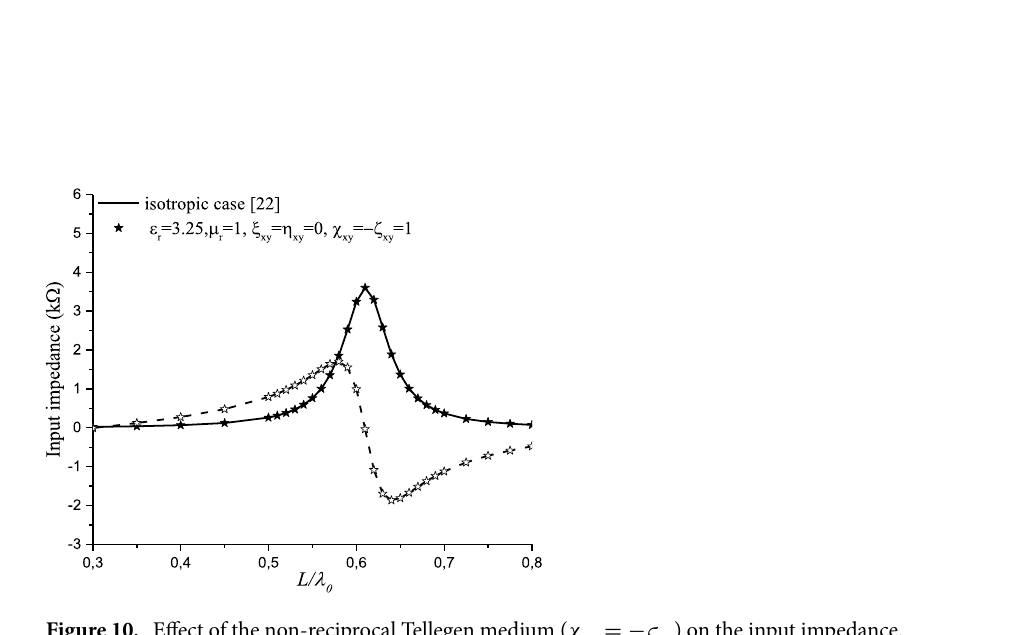
Figure 10. Effect of the non-reciprocal Tellegen medium ( χ xy